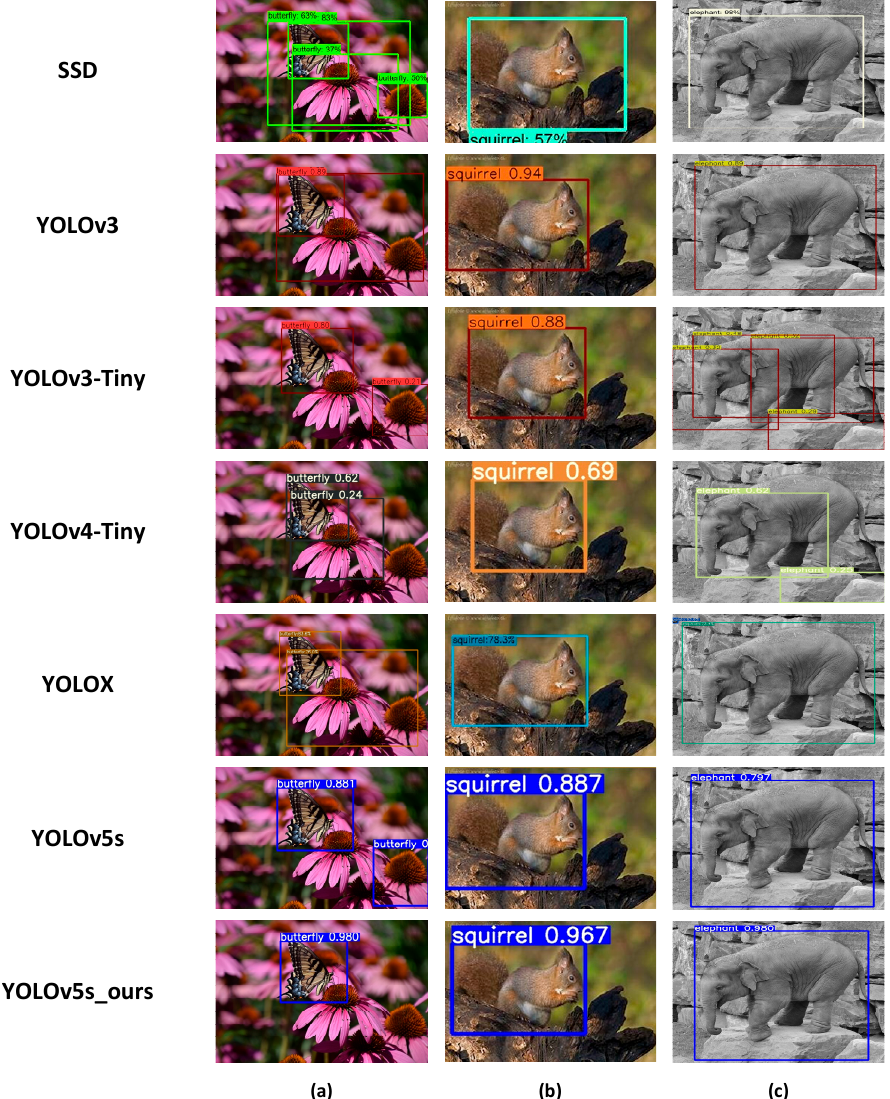
Figure 13. ( a ) Detection results with the butterfly; ( b ) detection results with the squirrel; ( c ) detection results with the elephant.